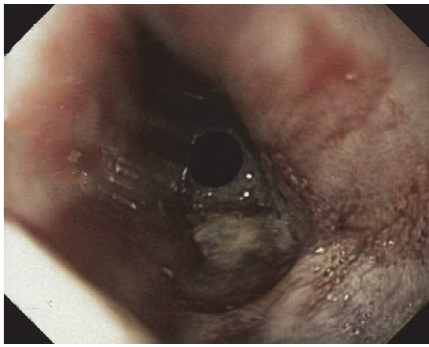
Figure 5: Follow-up EGD showed granulation tissue with inflam- mation at the site of fistula but no bleeding, no pulsating mass, and no